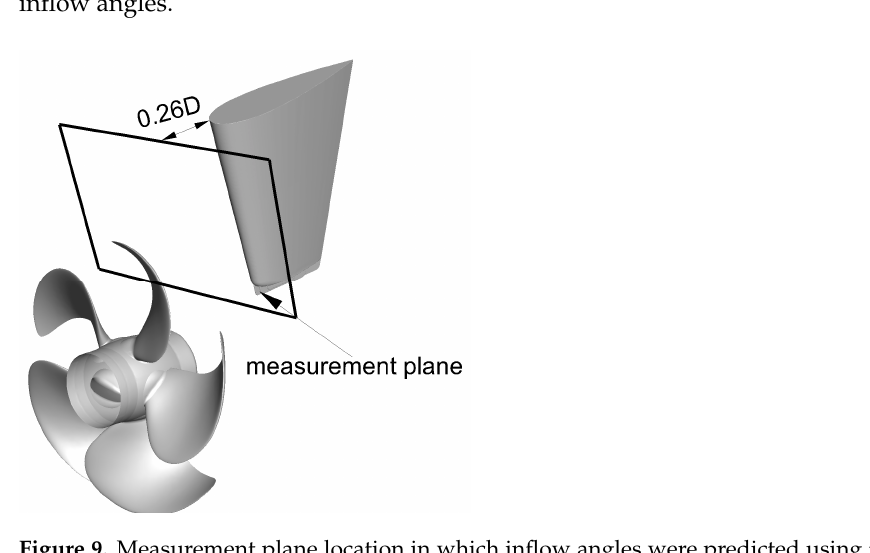
of those two velocities in front of the leading edge of the flat rudder: ( a ) axial velocity distribution;